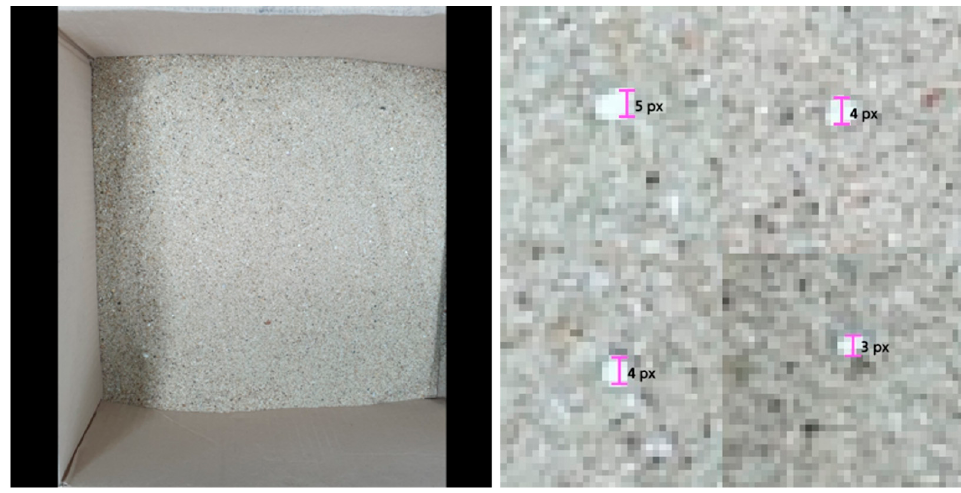
Figure 7. Original sand photo and a photo to show the size of microplastics.